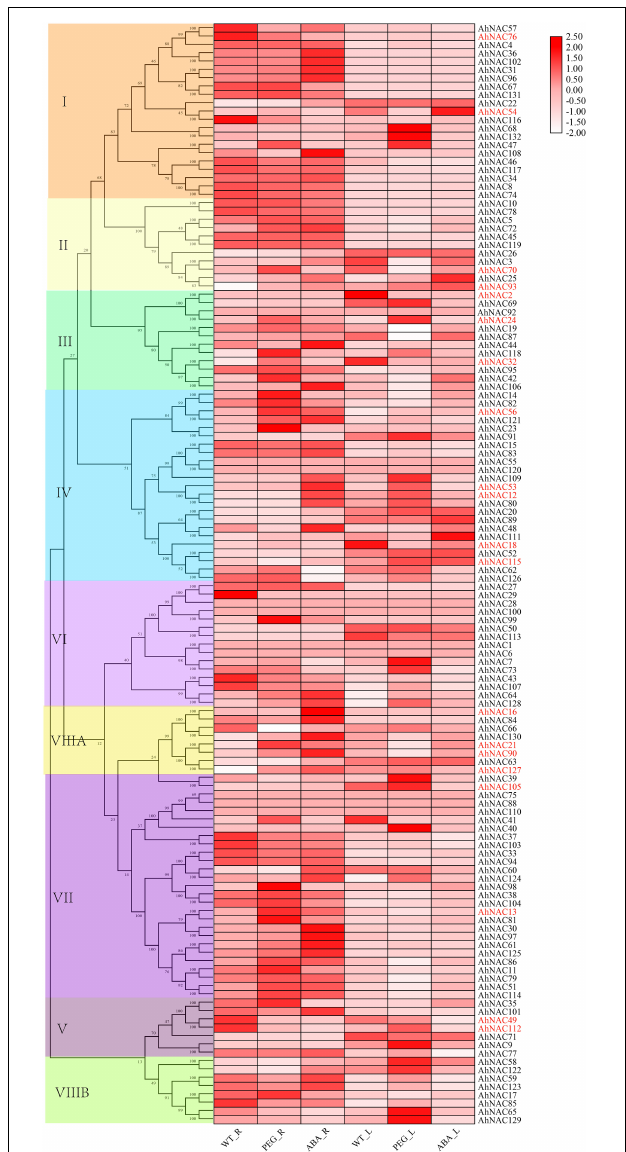
FIGURE 5 | Heat map presenting the expression patterns of AhNAC genes in roots and leaves treated with PEG and ABA. The relative expression values were transformed by log2 of FPKM values and are displayed as colored boxes from light pink to red, and genes selected by qPCR are indicated in red